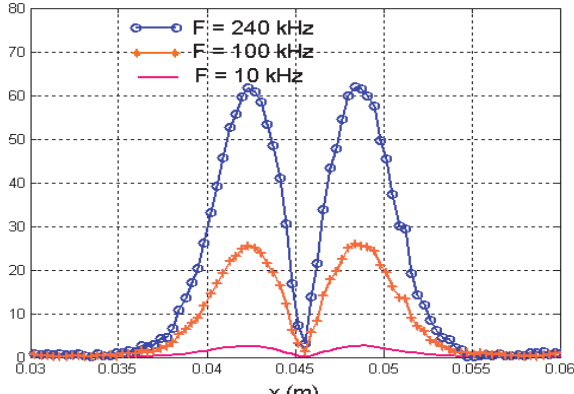
Figure 8: ∆ Z for F =10, 100 and 240 Khz.